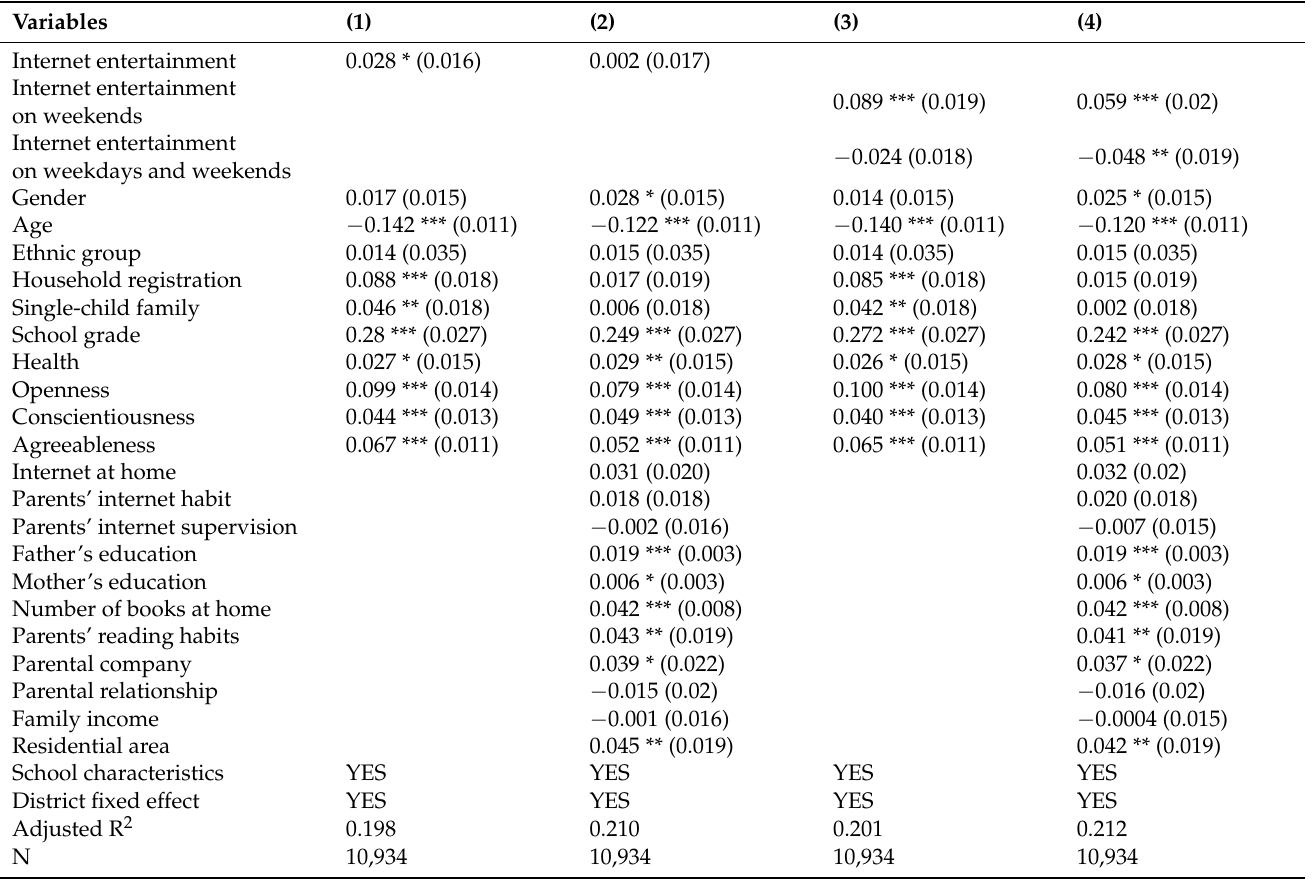
Table 2. Regression